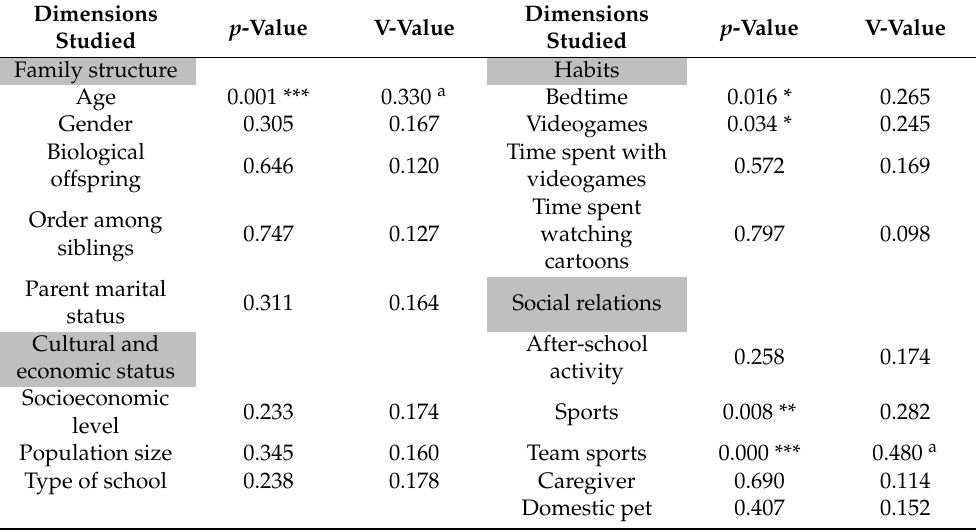
Table 4. Chi-square test and Cramer’s V applied to the different variables studied and the Wong– Baker faces scale.